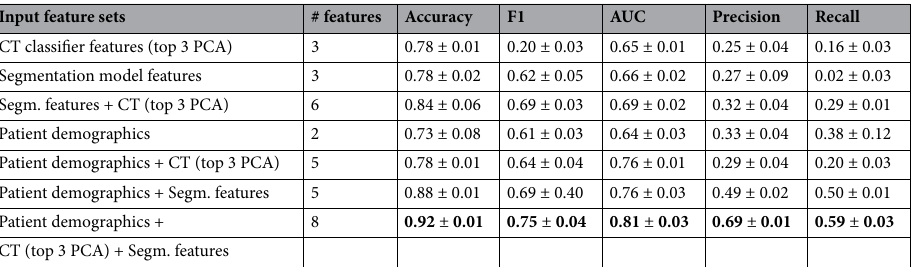
Table 4. Stony Brook University Prognosis Results with Leave One Out cross-validation. Significance values are in bold.